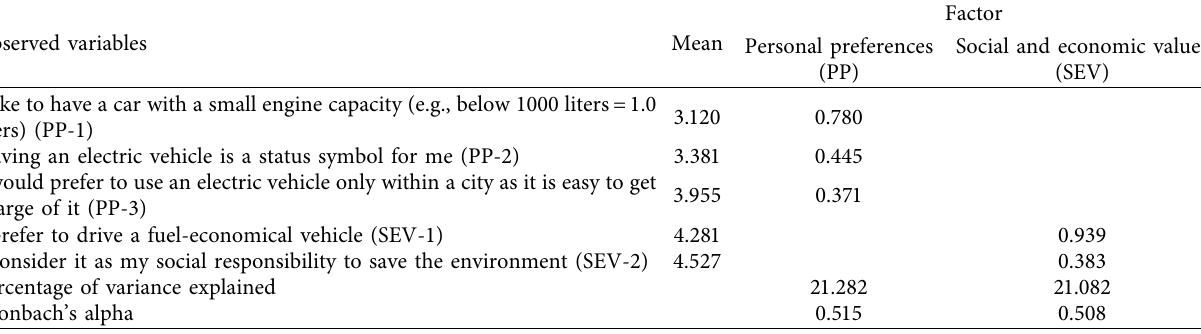
Table 5: Rotated factor loadings of extracted